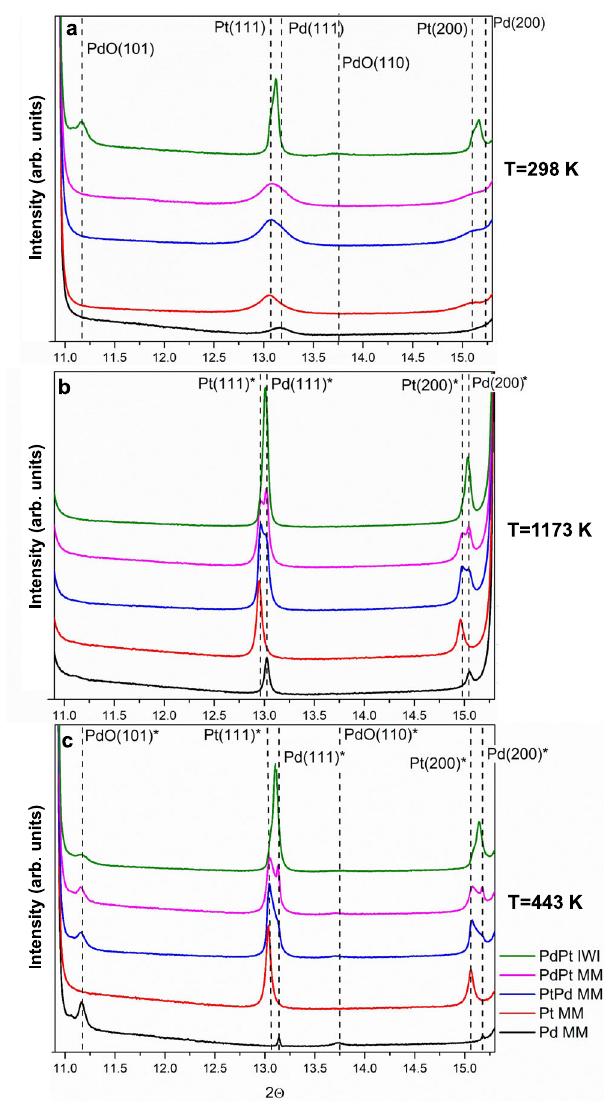
Fig. 1|DiffractogramsacquiredunderTPCconditions(CH 4 :O 2 :He=0.5:2:97.5). a Atroomtemperature, b 1173Kand c 443K(duringcoolingdown).Thepositionof the peaks marked with * is shifted due to temperature ( λ =0.5157Å).